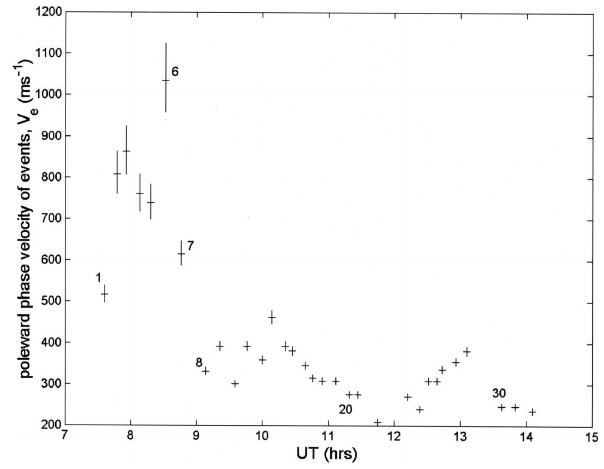
Fig. 7. The phase velocity of the poleward motion of the events, V e (from the slope of the fitted lines in the top panel of Fig. 5). The events are plotted at the time that they are at invariant latitude of 79 ◦ and selected events have been numbered for comparison with Fig. 5. Events after 11:00 (21–32) are discussed by Lockwood et al. (2001a, this